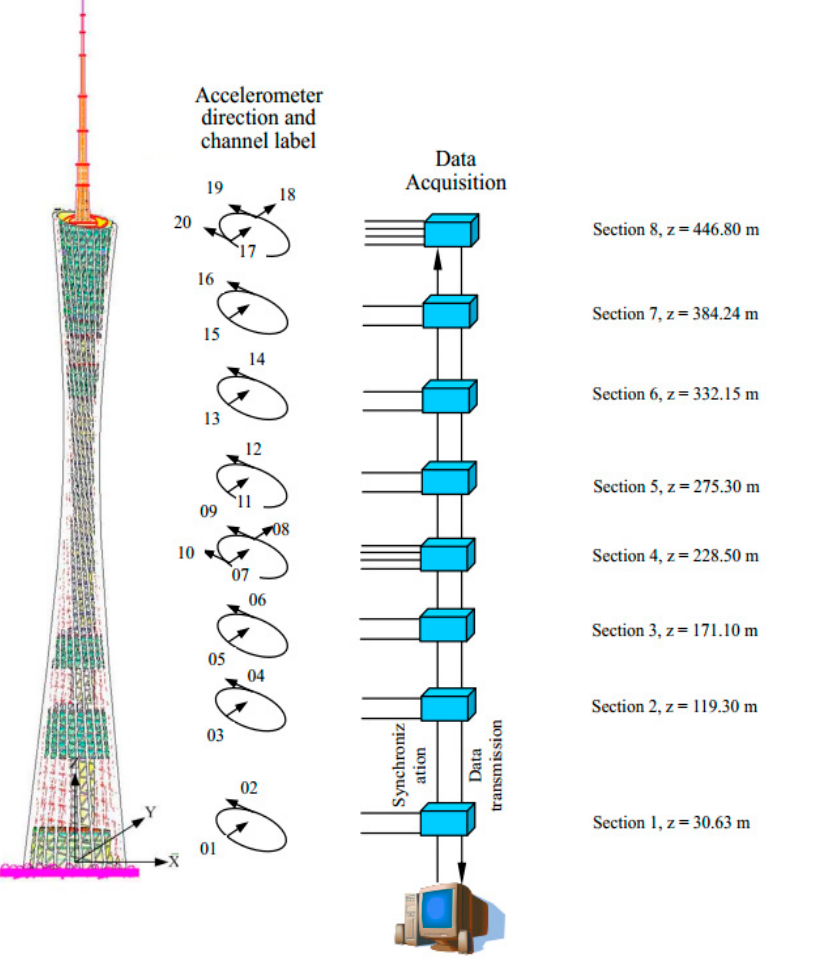
Figure 10. View of Canton Tower and monitoring system.